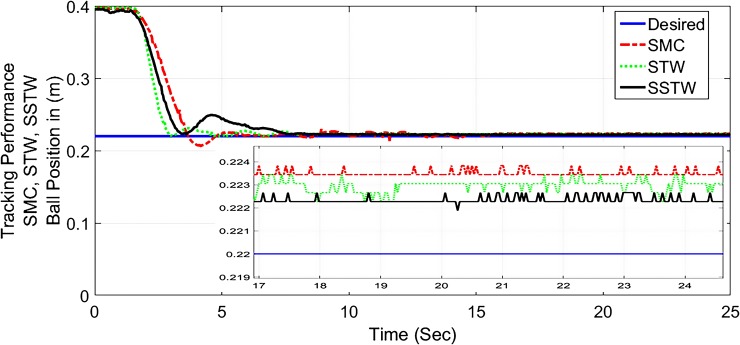
Output tracking performance of SMC, STW, and SSTW, rd = 22cm.